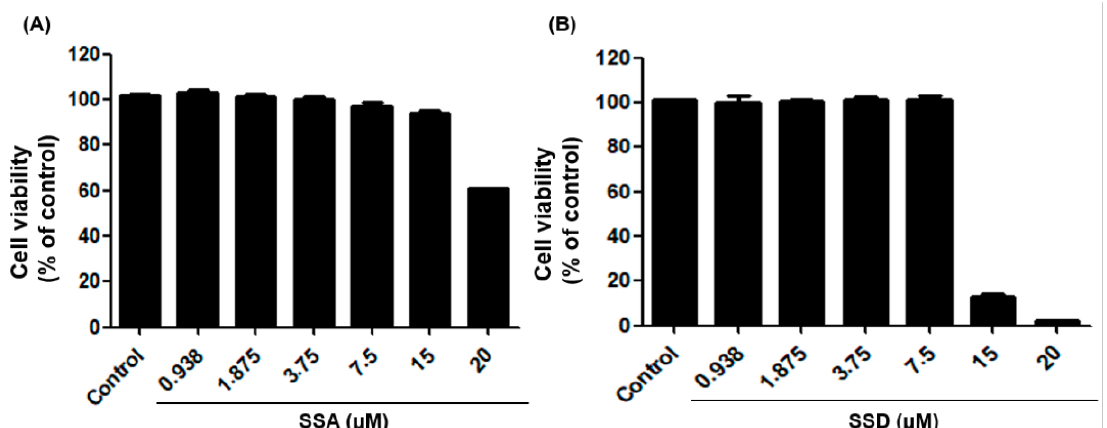
Figure 1. Effect of saikosaponin A (SSA, A ) and saikosaponin D (SSD, B ) treatment on cell viability in 3T3-L1 cells for 48 h. The cell viability was assessed by MTT assay. Data are expressed as a percentage of control (0.5% DMSO) value of triplicate